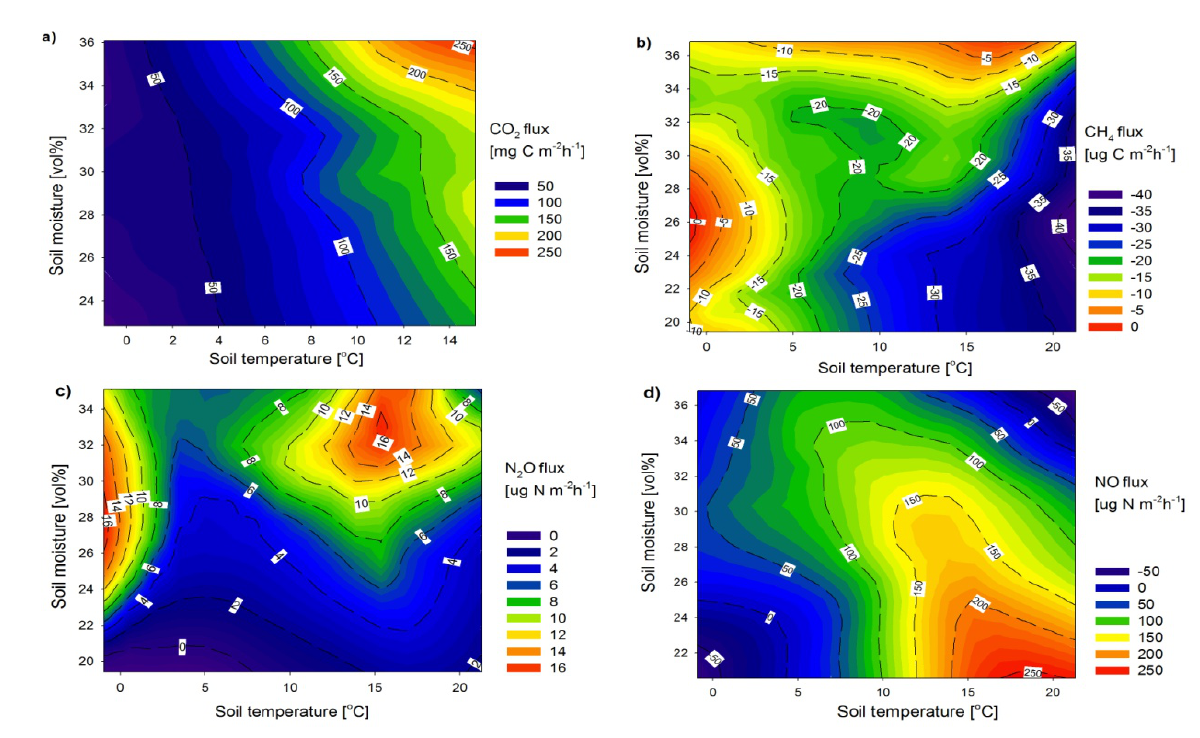
Fig. 7. Conjunct effects of soil moisture (in 10cm soil depth) and temperatures (in 5 soil depth) on monthly means of soil trace gases fluxes (a) CO 2 ; (b) CH 4 ; (c) N 2 O fluxes; note that for the analysis of N 2 O fluxes freeze-thaw periods were excluded; (d) NO fluxes. Prior to the calculation of contour lines, data were smoothed with the Loess algorithm (sampling proportion = 0.3-0.5).